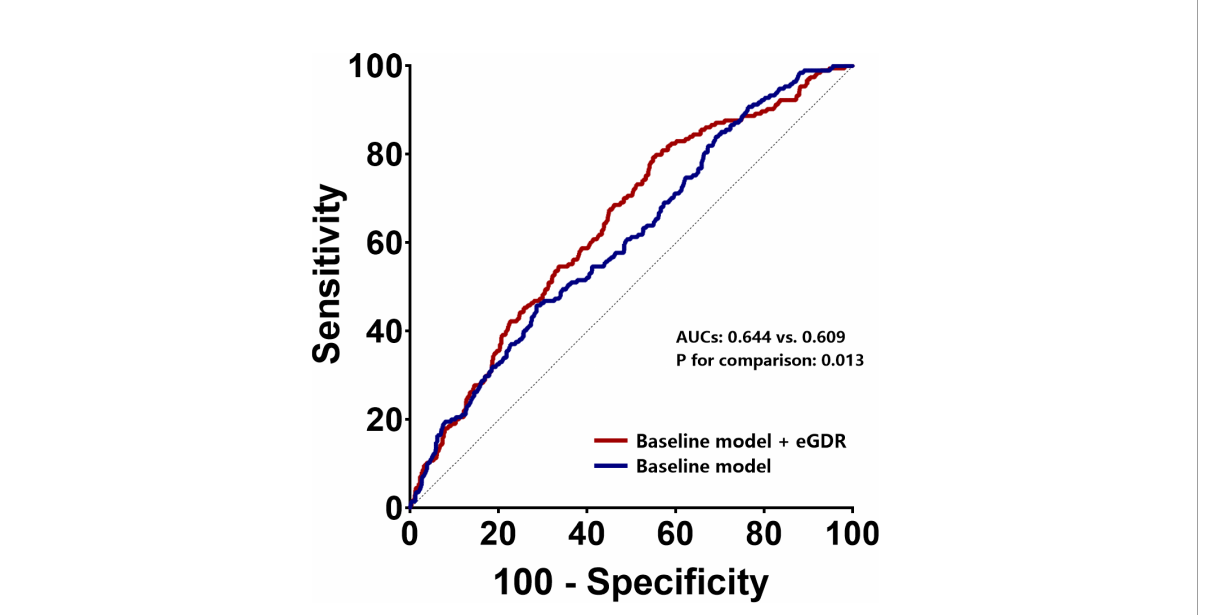
FIGURE 3 ROC curves to assess the predictive value of eGDR for ISR in general population. ROC receiver-operating characteristic, eGFR estimated glomerular fi ltration rate, ISR in-stent restenosis, AUC area under curve.